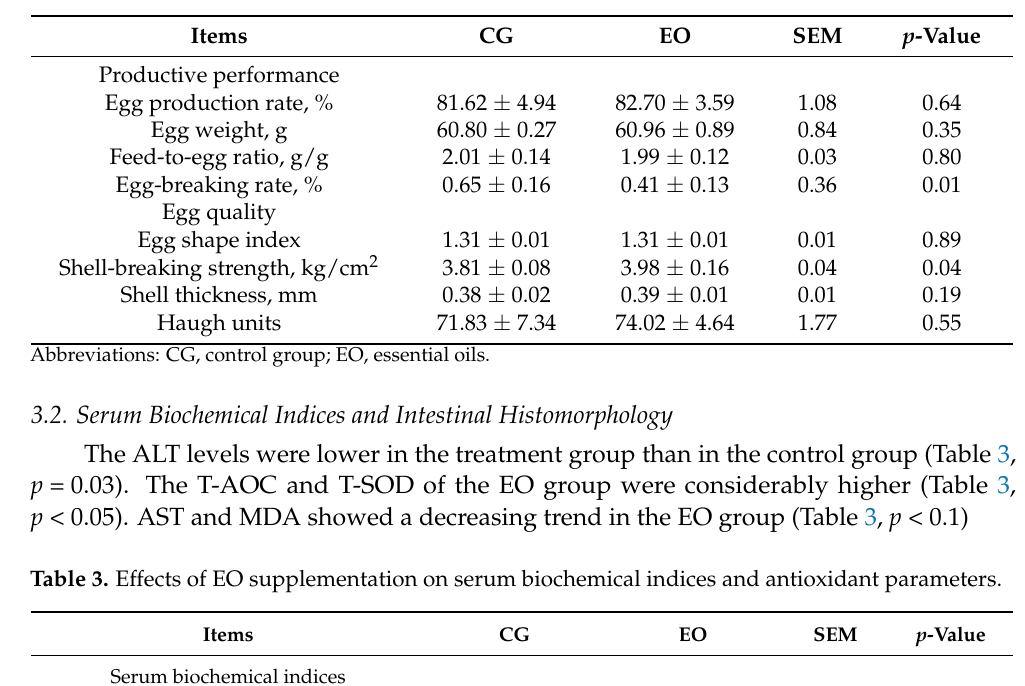
Table 2. Effects of EO supplementation on productive performance and egg quality.